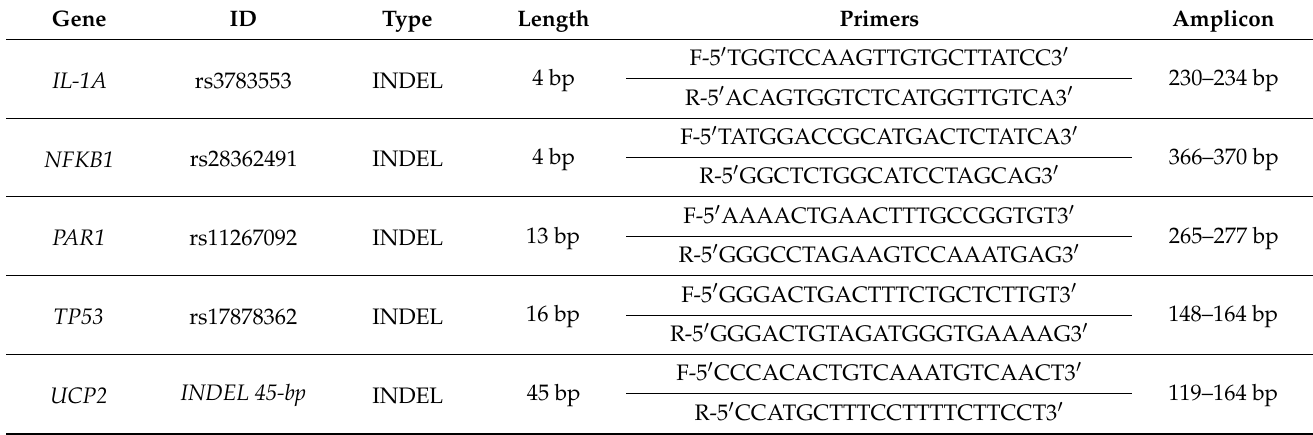
Table 1. Technical characteristics of the markers studied.